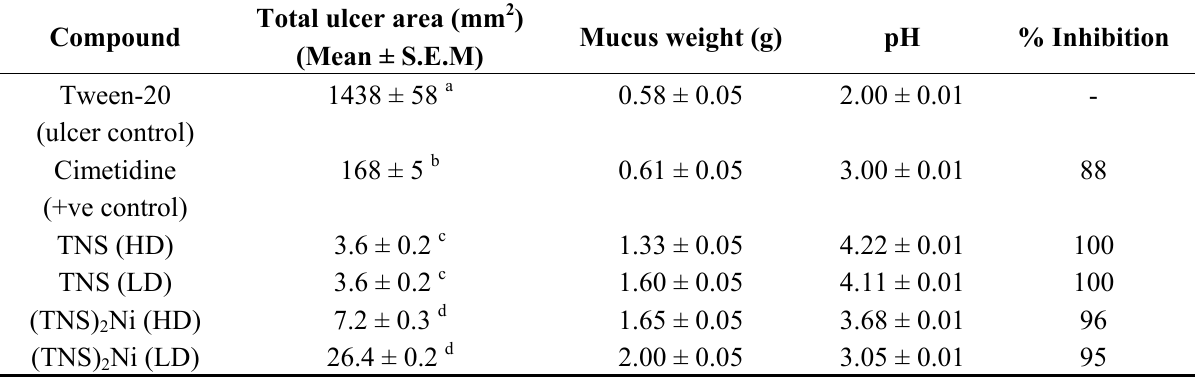
Table 1. Effect of TNS and its nickel (II) complex on ulcer area, mucus weight, pH and inhibition percentage in